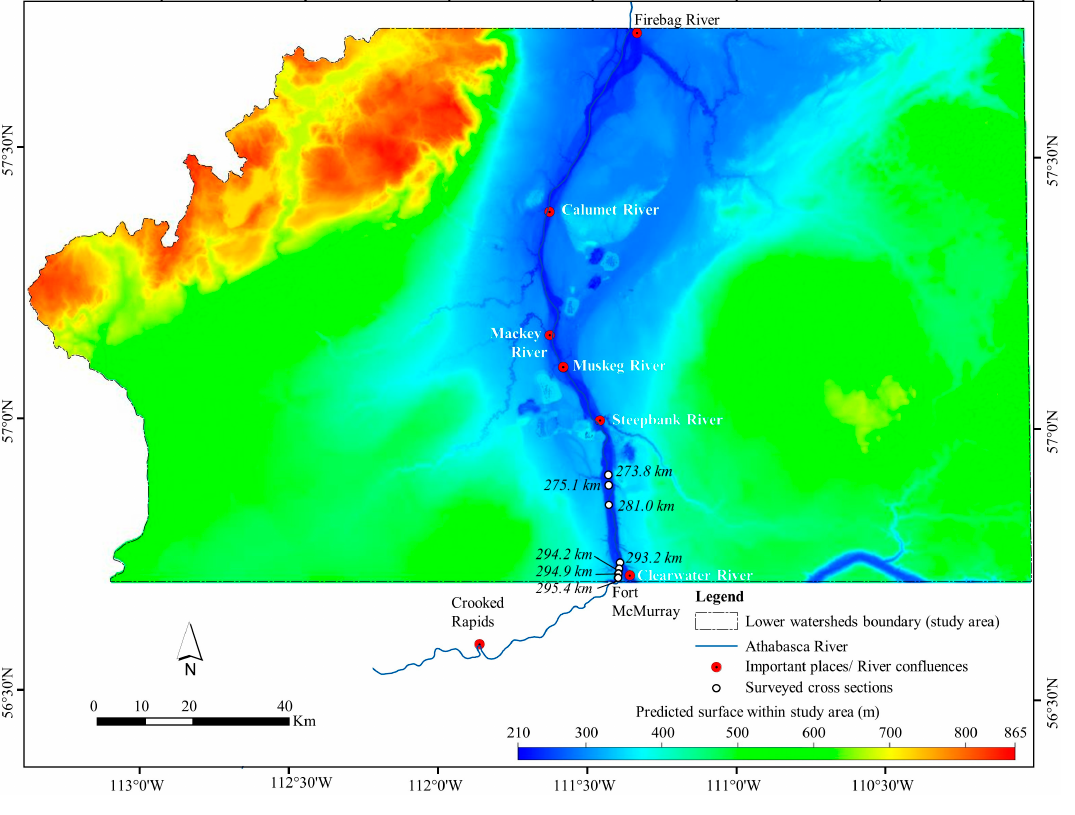
Figure 7. The lower Athabasca River watershed DEM at 5 m × 5 m spatial resolution.